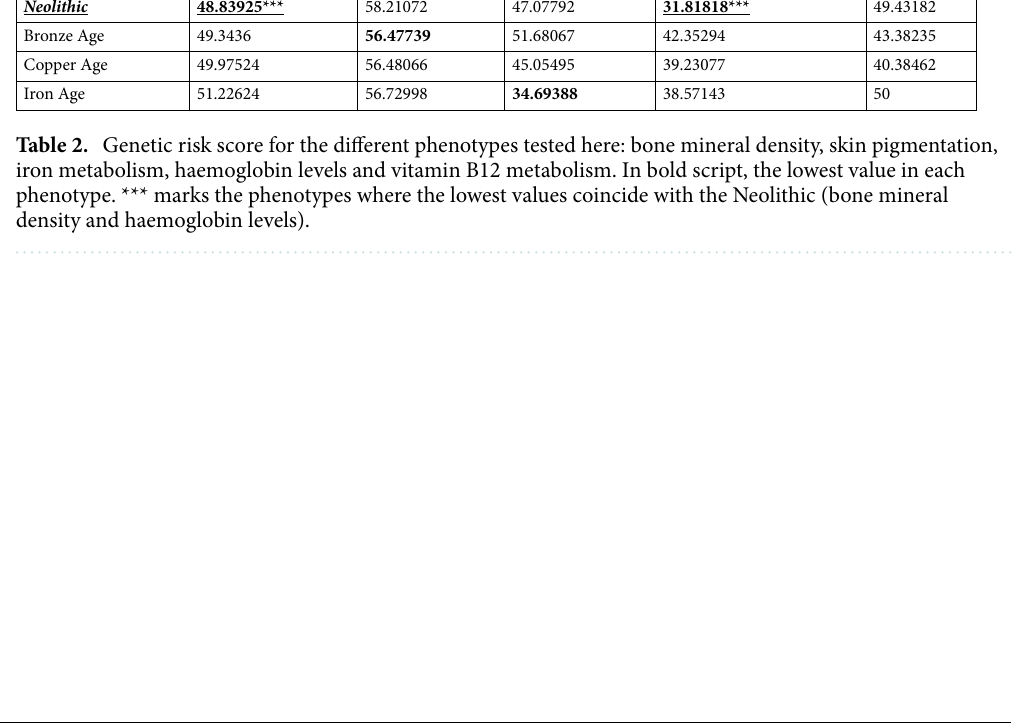
Period BMD GS*** SKIN GS IRON